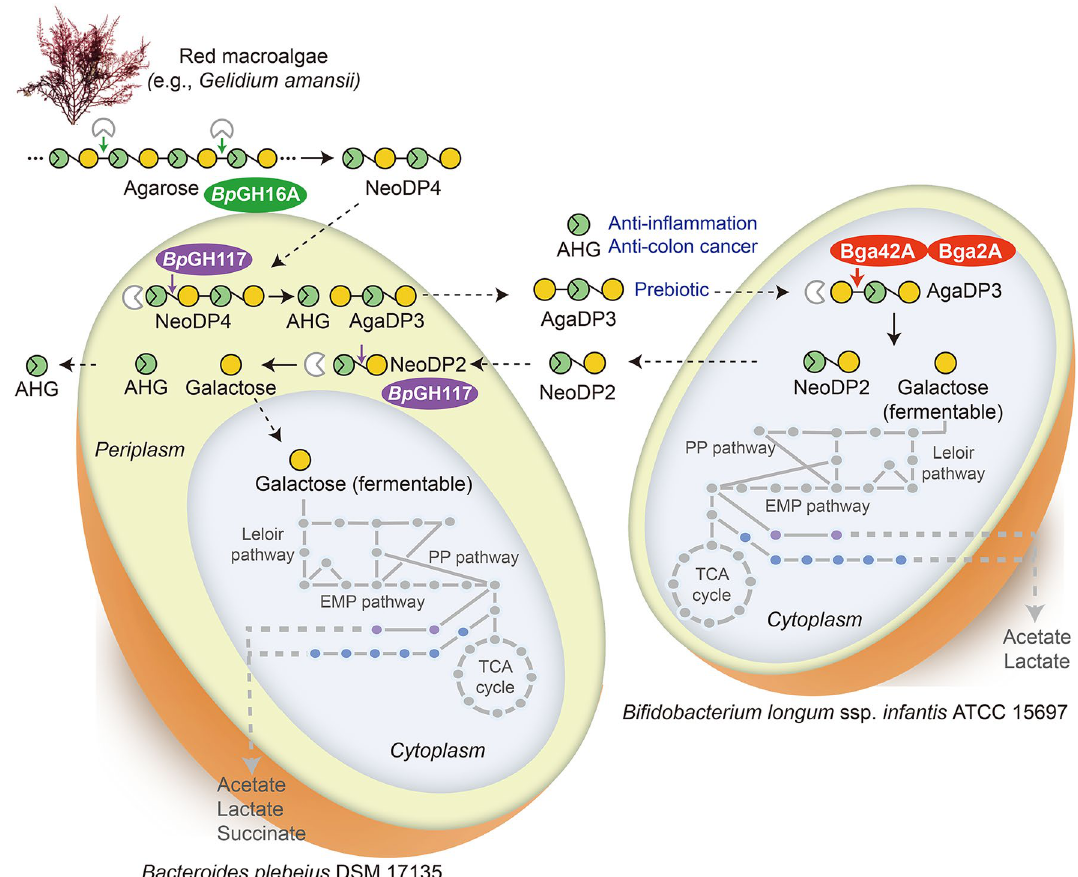
Figure 5. Cooperative actions of two distinct gut bacteria, B. plebeius and B . infantis , enable the complete degradation of seaweed agar. Agarose is initially decomposed into NeoDP4 by Bp GH16A, and NeoDP4 is then further hydrolyzed into AgaDP3 and AHG by Bp GH117. B. infantis hydrolyzes AgaDP3 into NeoDP2 and galactose using Bga42A or Bga2A. Finally, NeoDP2 is hydrolyzed into the monomeric sugars, galactose and AHG by Bp